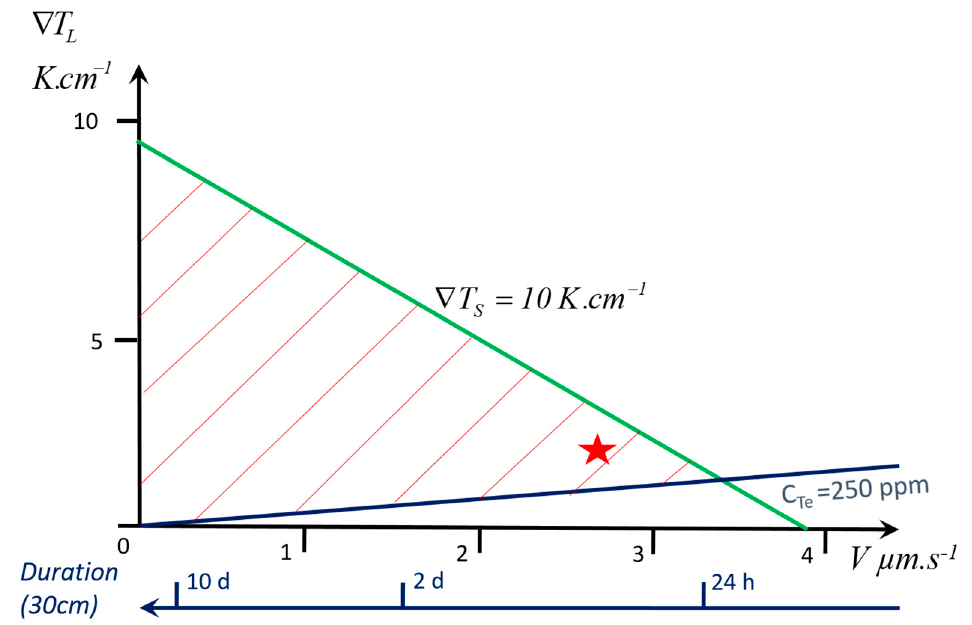
Figure 3. Diagram obtained for the optimization of the growth of Te:GaSb single crystals.